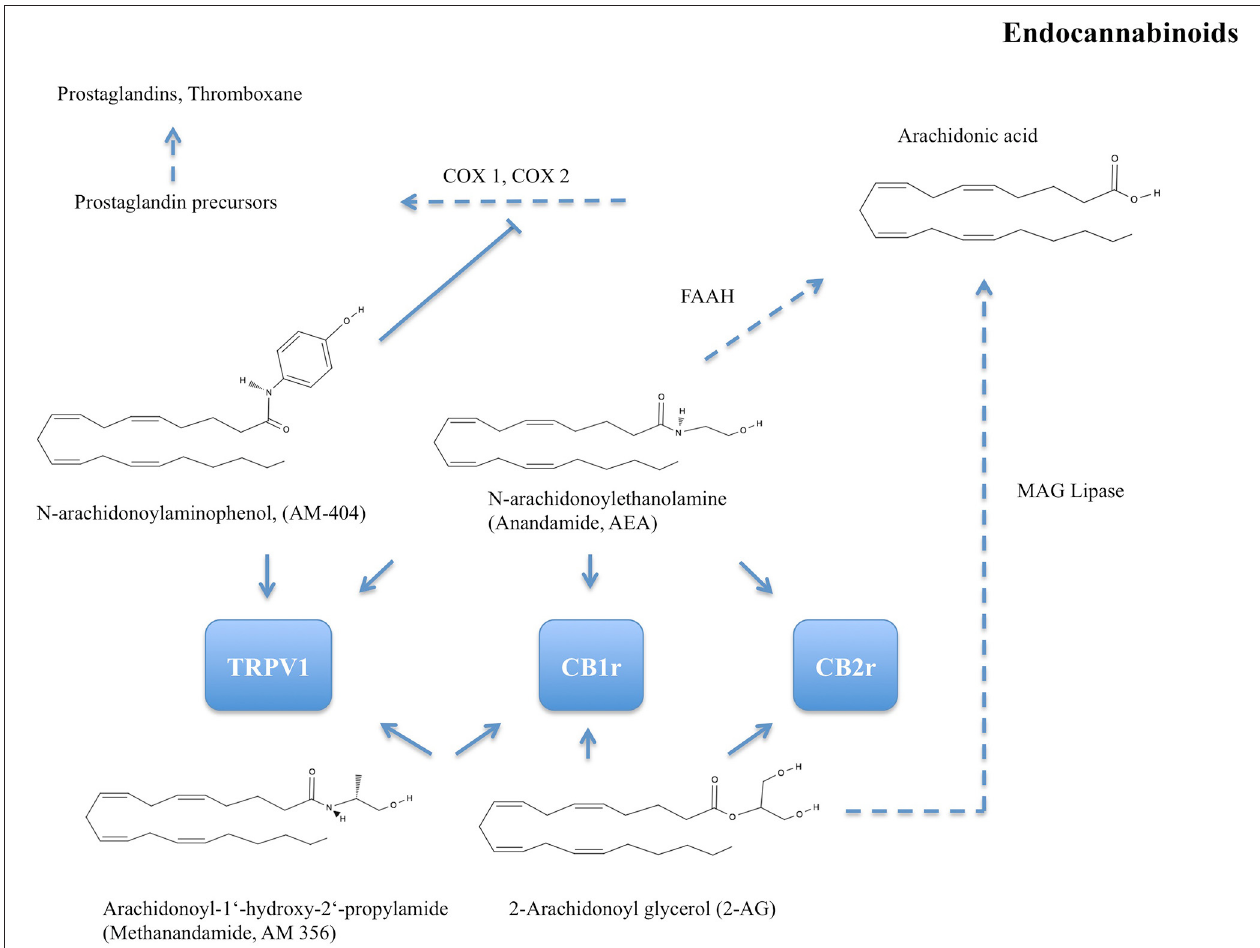
FIGURE 2 | Chemical structures of major endocannabinoids: N-arachidonoylethanolamine (Anandamide or AEA), 2-Arachidonoyl glycerol (2-AG), and N-arachidonoylaminophenol (AM-404). One of their synthetic analogs is Arachidonoyl-1’hydroxy-2’-propylamide (Methanandamide or AM-356). AEA is hydrolyzed by fatty acid amino hydrolase (FAAH) to 5,8,11,14-Eicosatetraenoic acid (arachidonic acid). 2-AG is hydrolyzed by monoacylglycerol (MAG) lipase to arachidonic acid. Arachidonic acid is metabolised via prostaglandin precursors to vasodilative prostaglandins and thromboxane by cyclo-oxygenase (COX-) 1 and 2. AM-404 is